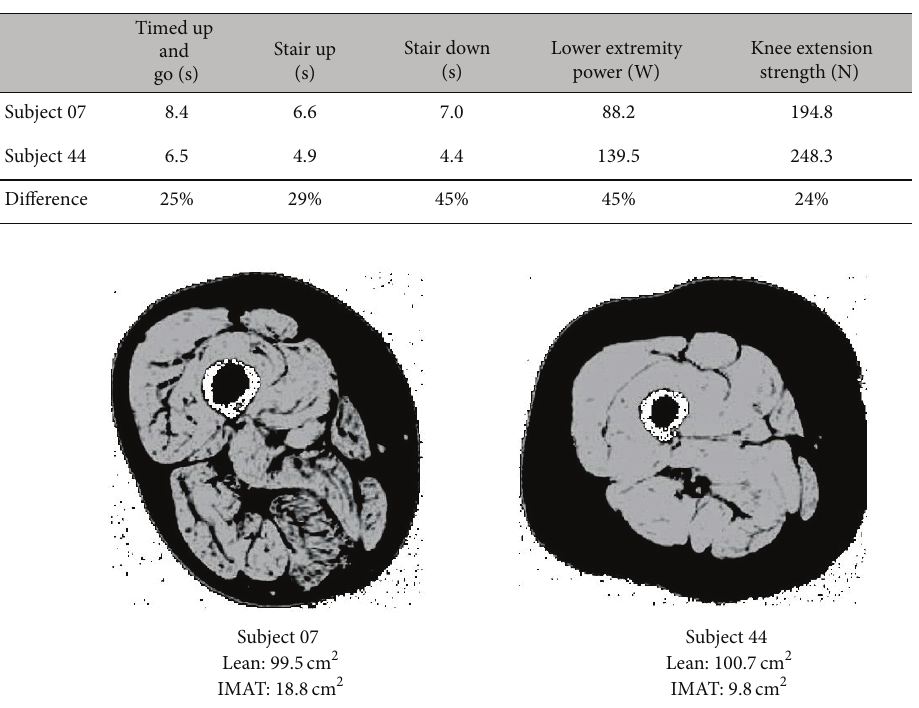
Figure 3: Two women with similar age, BMI, and levels of lean muscle mass but with differing levels of IMAT in a cross-sectional MRI image of the thigh. Subject 7 has double the level of IMAT (black within the muscle) in her thigh as subject 44. While both women have similar levels of lean tissue (seen in grey), they have different levels of mobility and muscle function. The increased levels of IMAT and decreased muscle and mobility function of subject 7 are consistent with literature that reports that increased levels of IMAT are associated with decreased muscle and mobility